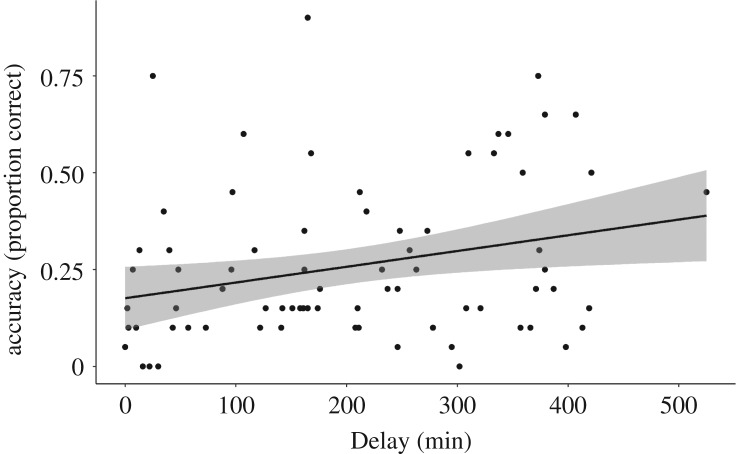
Recall mean per cent accuracy at re-test correlated with Delay collapsed across Exposure conditions.